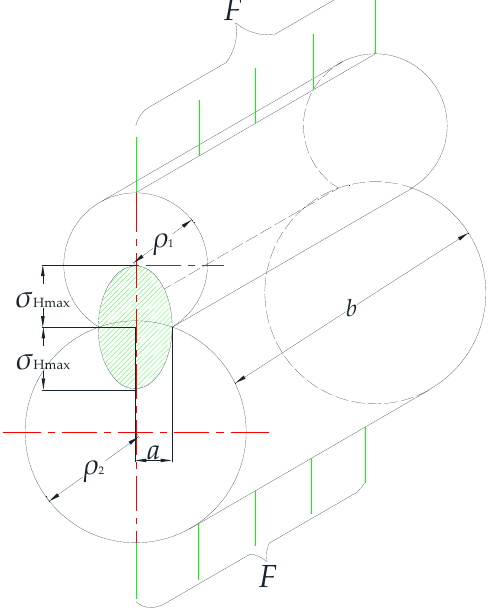
Figure 1. Hertz contact model.